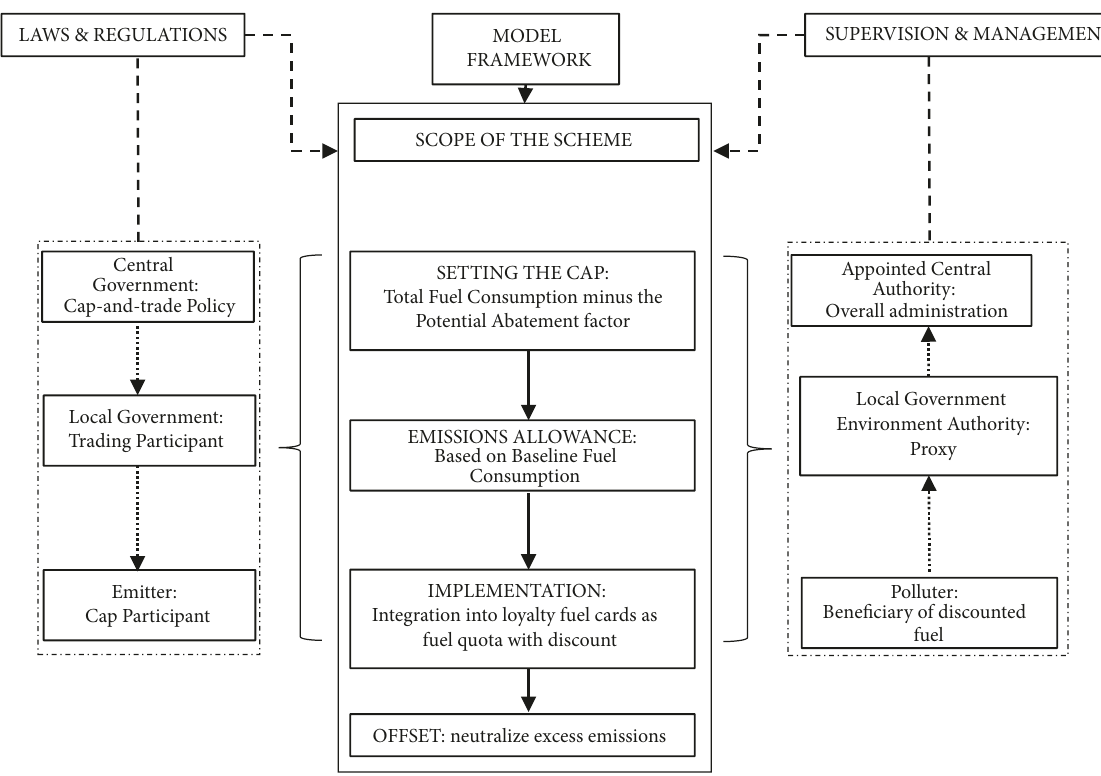
Figure 3: Overall structure of the institutional